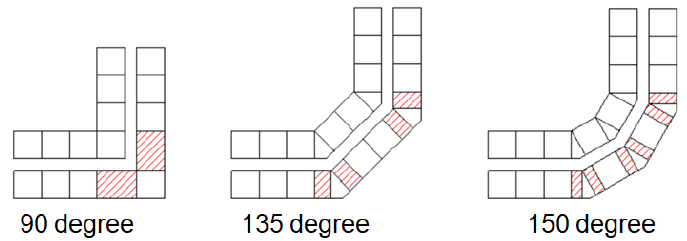
Figure 4. Unbalanced sections in bend structures with 90-, 135-, and 150-degree bends.